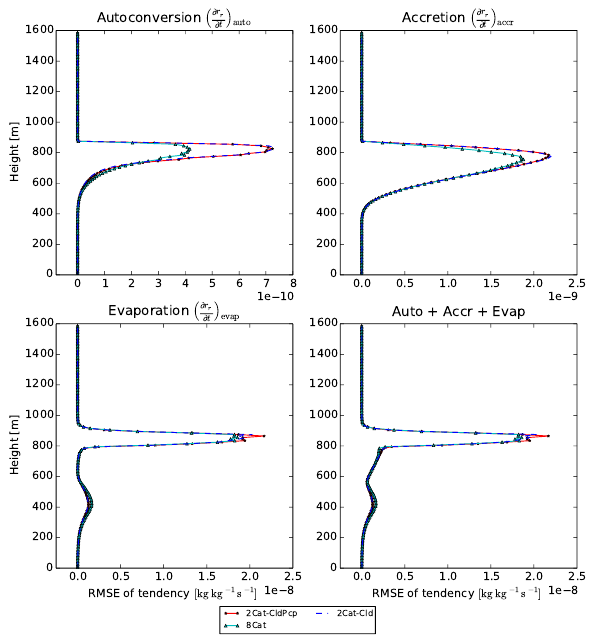
Figure 8. DYCOMS-II RF02: profile RMSE plots of the four ten- dencies. The simulations in these plots use 32 sample points. For each configuration, an ensemble of 12 simulations is used, each with a different seed. RMSE values are averaged over all 360 timesteps of the simulation and all 12 ensemble members. All sampling meth- ods show the largest RMSE at around 800m. At this level, the 8Cat method shows smaller error in autoconversion and accretion, but all methods show about the same error in evaporation.